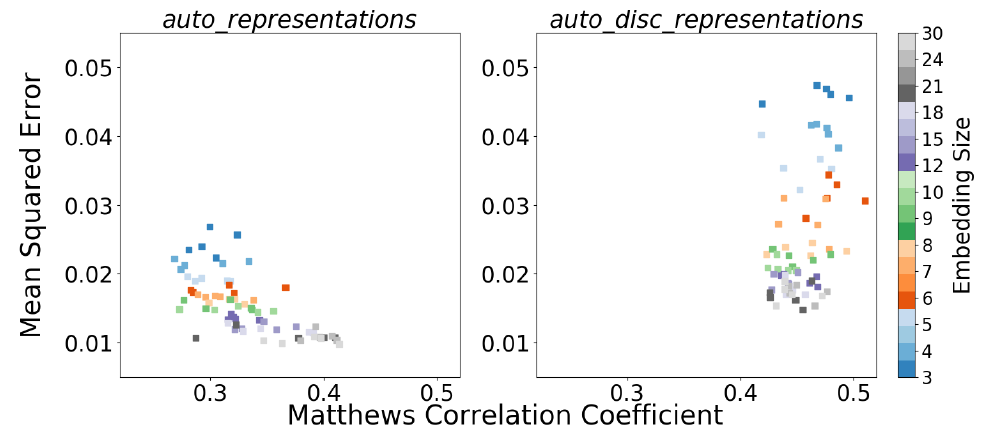
Figure 6. Comparison between recognition performances (in MCC) and reconstruction performances (in MSE) using ( left panel ) the auto_representations and ( right panel ) the auto_disc_representations .